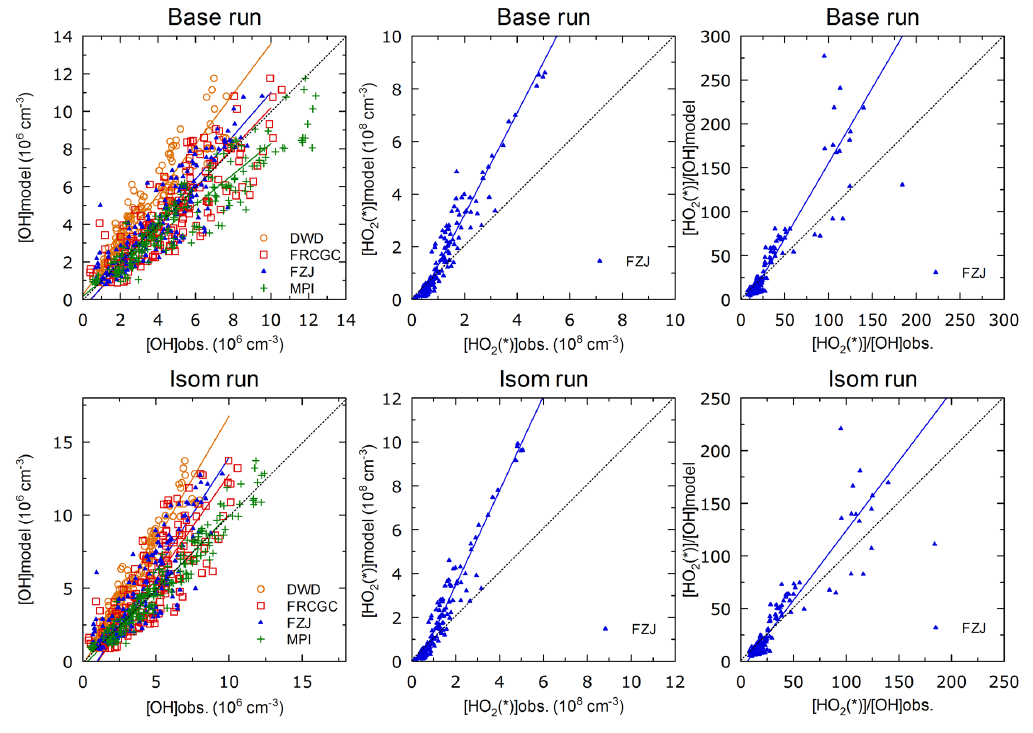
Fig. 3. Scatterplots between observed OH and HO 2 (*) concentrations and HO 2 (*)/OH ratios, and those modeled in the Base run (upper panels) and in the Isom run (lower panels). Linear regression lines are shown by colored solid lines and one-to-one lines are given as black dotted